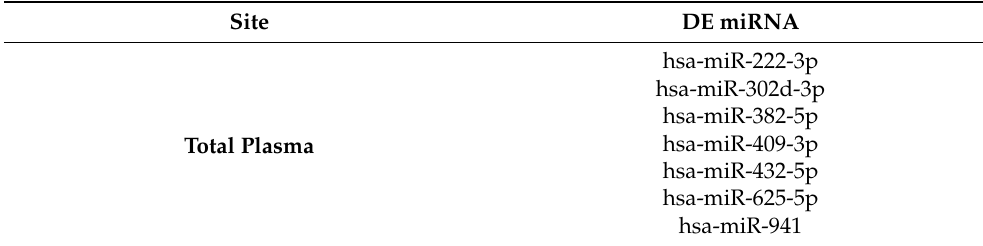
Table 3. Total plasma and extracellular vesicles (EVs) differentially expressed (DE) miRNAs of the discovery cohort involved in GDM-related